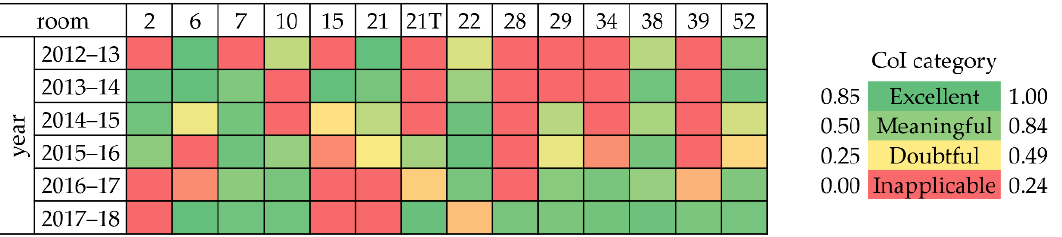
Figure 6a,b shows the box-and-whisker plots of T and RH data, respectively, recorded in each room and outside (data retrieved from ERA5 database, labelled as “out”) over the selected period. Tables 2 and 3 synthetically report the main statistical parameters for the interpretation of box-and-whisker plots. Outliers were visible only in RH plots (Figure 6b, black dots), although they were not excluded in the following analyses. In general, it can be noted that T boxes overlap in all rooms, whereas RH boxes behave differently among the rooms.